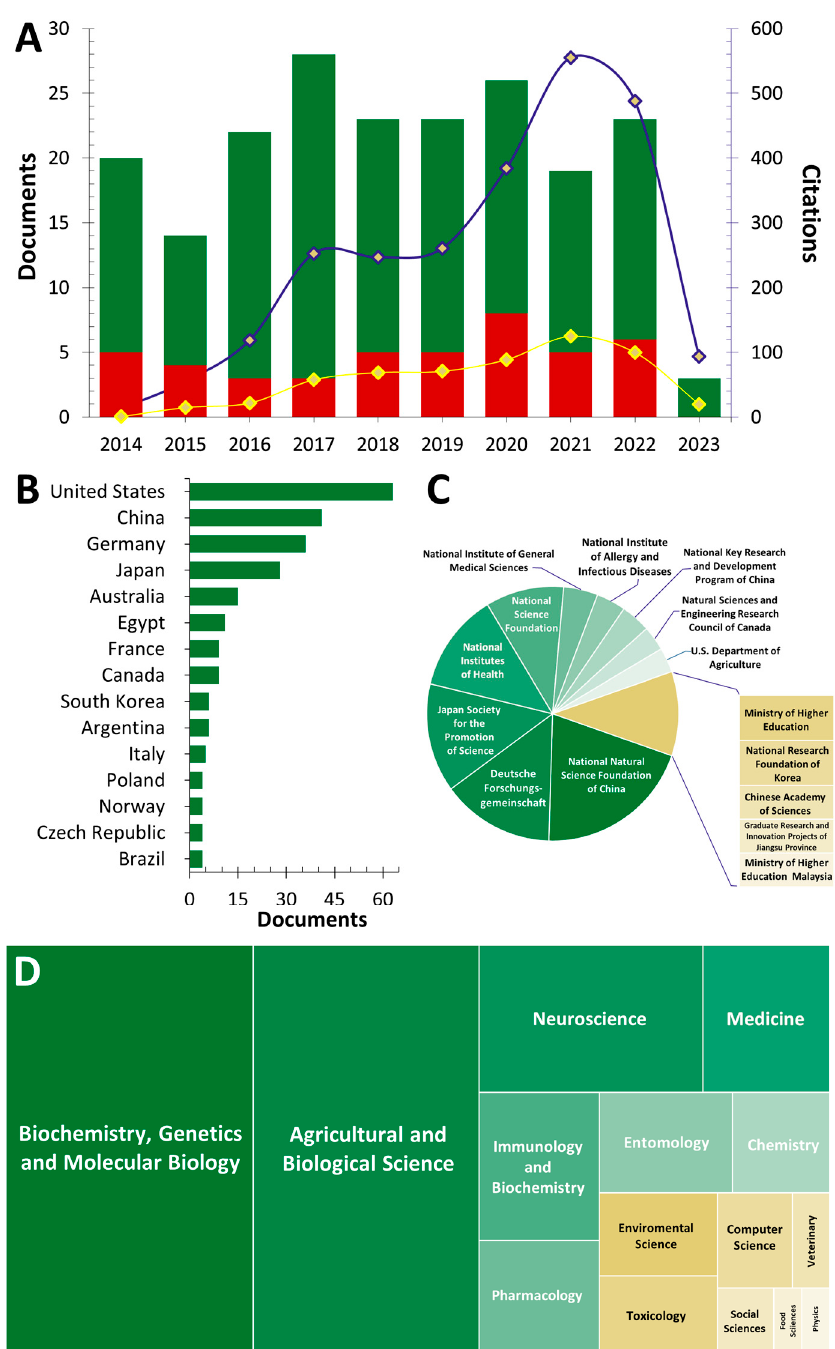
Figure 3. Representation of bibliometric data derived from 201 articles included in the database and obtained using “Biogenic Amines AND Social Insects” as the search string. Panel ( A ) shows the trend of publications and citations in the time interval 2014–2023 (green bars and blue line). In the same panel, the red bars and the yellow line refer to publications related to ants. Panel ( B ) lists the leading countries of authors by the number of publications. Panel ( C ) shows the affiliations of the authors who contributed the most to the research topic. Panel ( D ) shows the scientific fields involved in the topic of